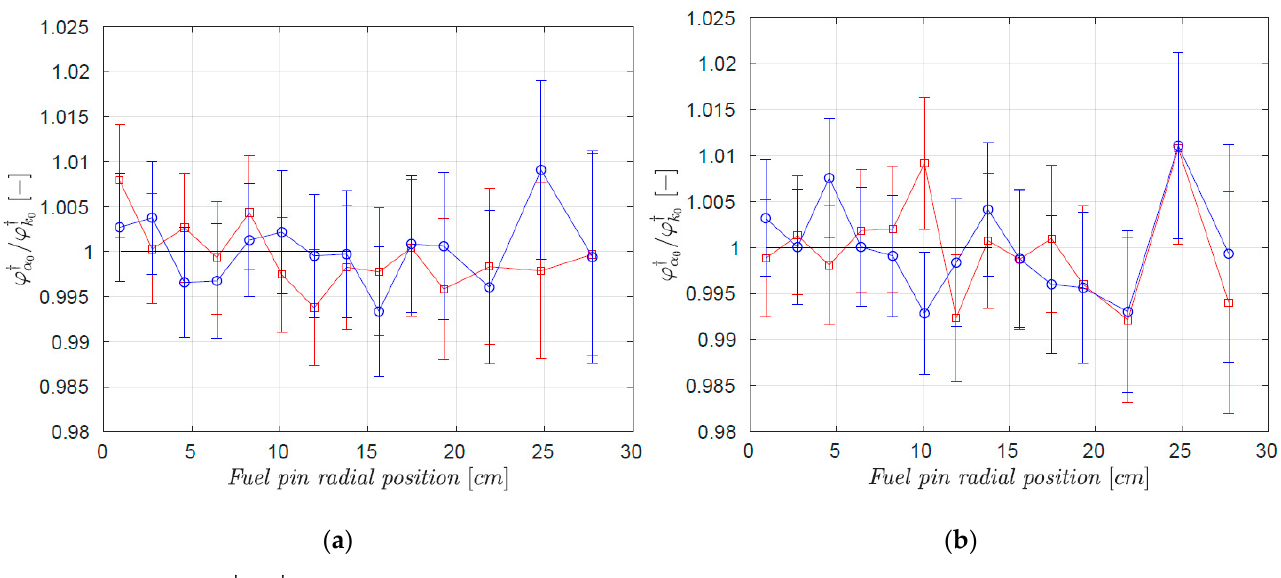
Figure 15. Ratios ϕ † α / ϕ † of the CROCUS reactor as a function of the fuel pin positions, H1 ( a ) and H2 ( b ) configurations with (red squares) and without (blue circles) precursor contributions. Table 21. Effective kinetics parameters for the H1 configuration without delayed contributions.